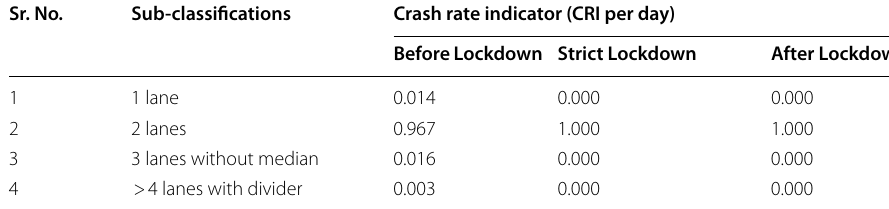
Table 6 CRI by road feature Sr. No.